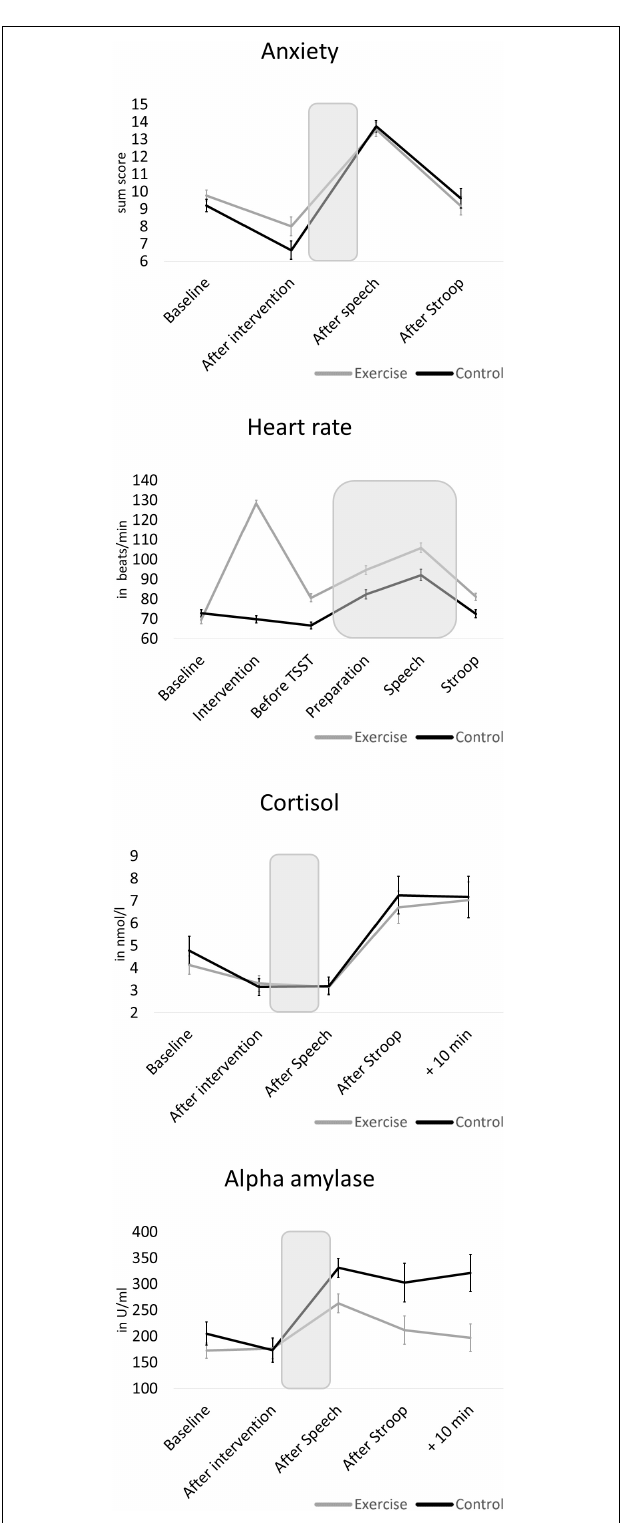
FIGURE 3 | Mean physiological and psychological stress reactivity of the exercise group and the control group. The shaded areas indicate the stressor (preparation and speech task). Error bars are standard errors of the mean (SEM).